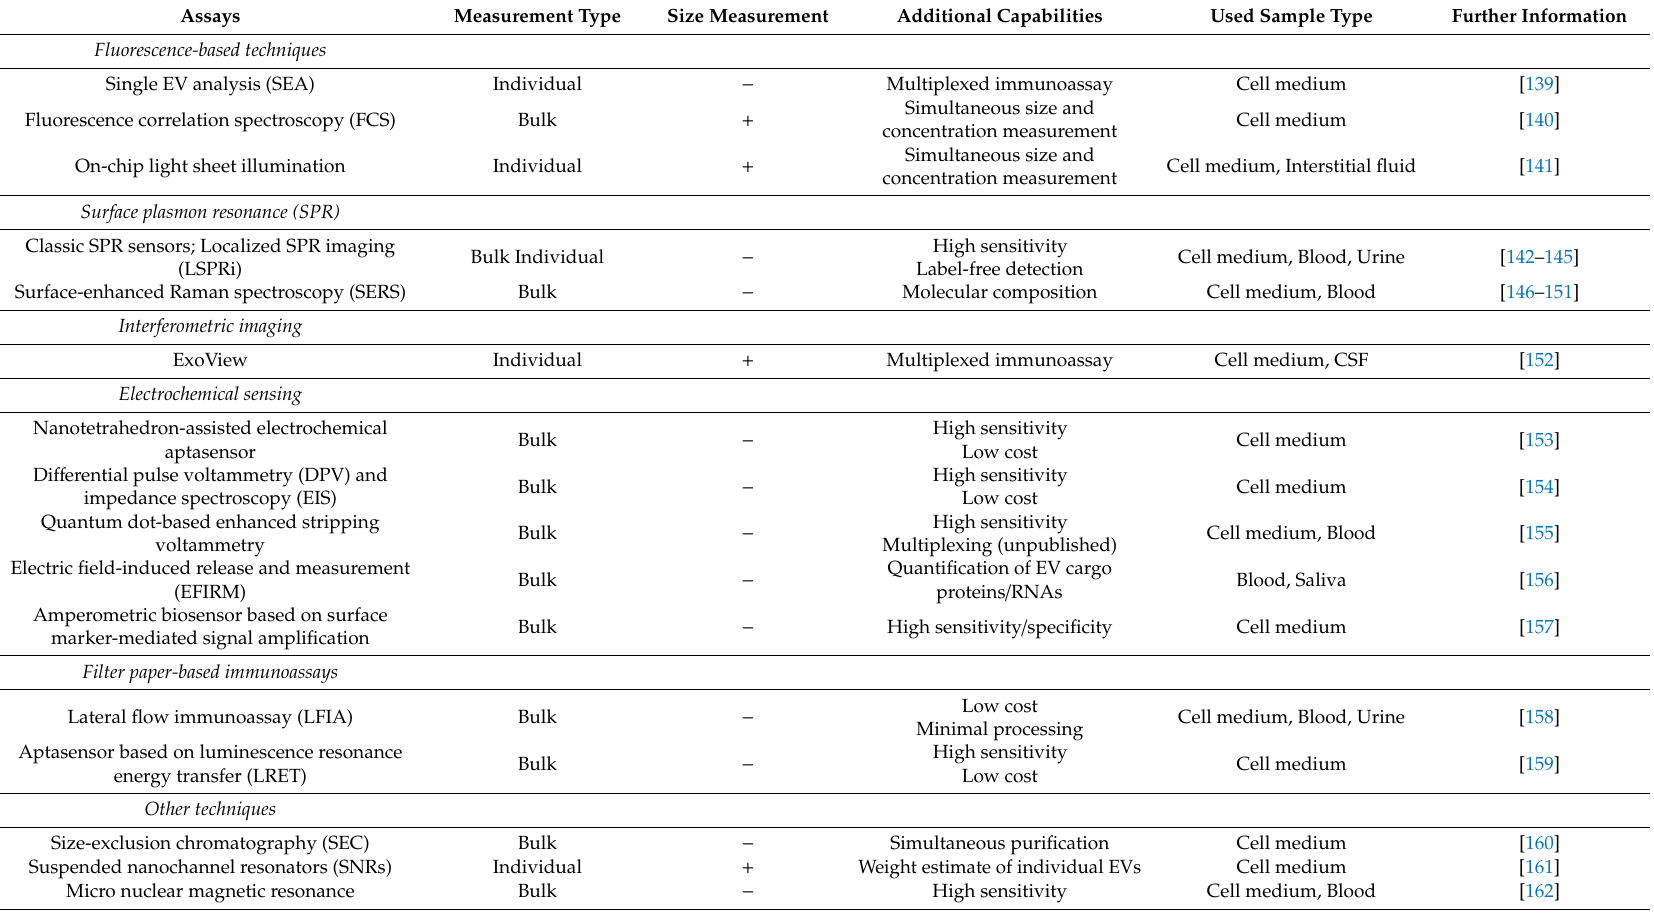
Table 2. Summary of the properties of emerging approaches for EV analysis categorized by the main principle of EV detection.